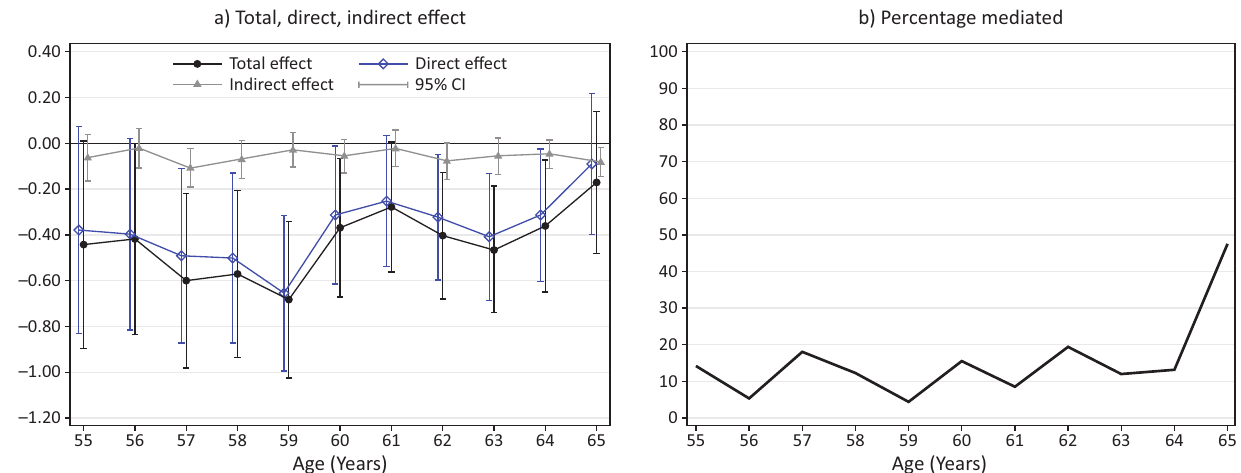
Figure 7. KHB mediation analysis of total, direct, and indirect effects of general versus vocational education on employment probability (not) via health for men. Notes: Total and direct effect of general versus vocational education on age-specific employment probabilities. Indirect effects via health are significant at age 57 and 65. Figure 7a reports log odds. Mediator variables include nights spent in hospital, doctor visits, disability status, and health satisfaction. Control variables include period effects, cohort effects, German nationality, parental educational background, residence in West Germany, and edu- cational level. N persons = 6,026; N person-years = 32,469. Detailed regression results available upon request. Data source: GSOEP